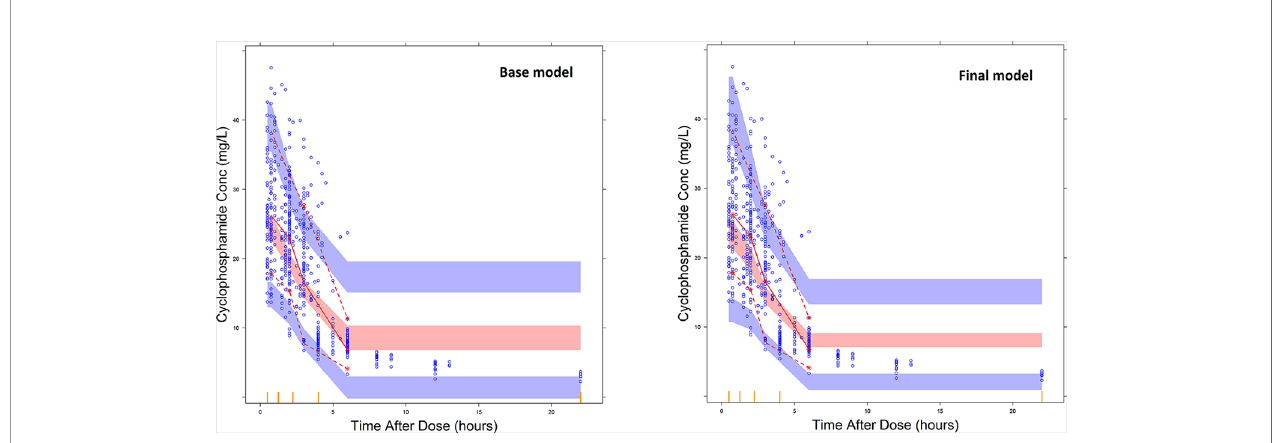
FIGURE 3 | Prediction corrected visual predictive check plots for the base model and fi nal covariate models. The blue dots represent the distribution of observed plasma CPA concentrations and the broken lines represent the 5 th (bottom) and 95 th percentile (top line) of the median observed data. The shaded regions represent the 95% prediction interval for the observed